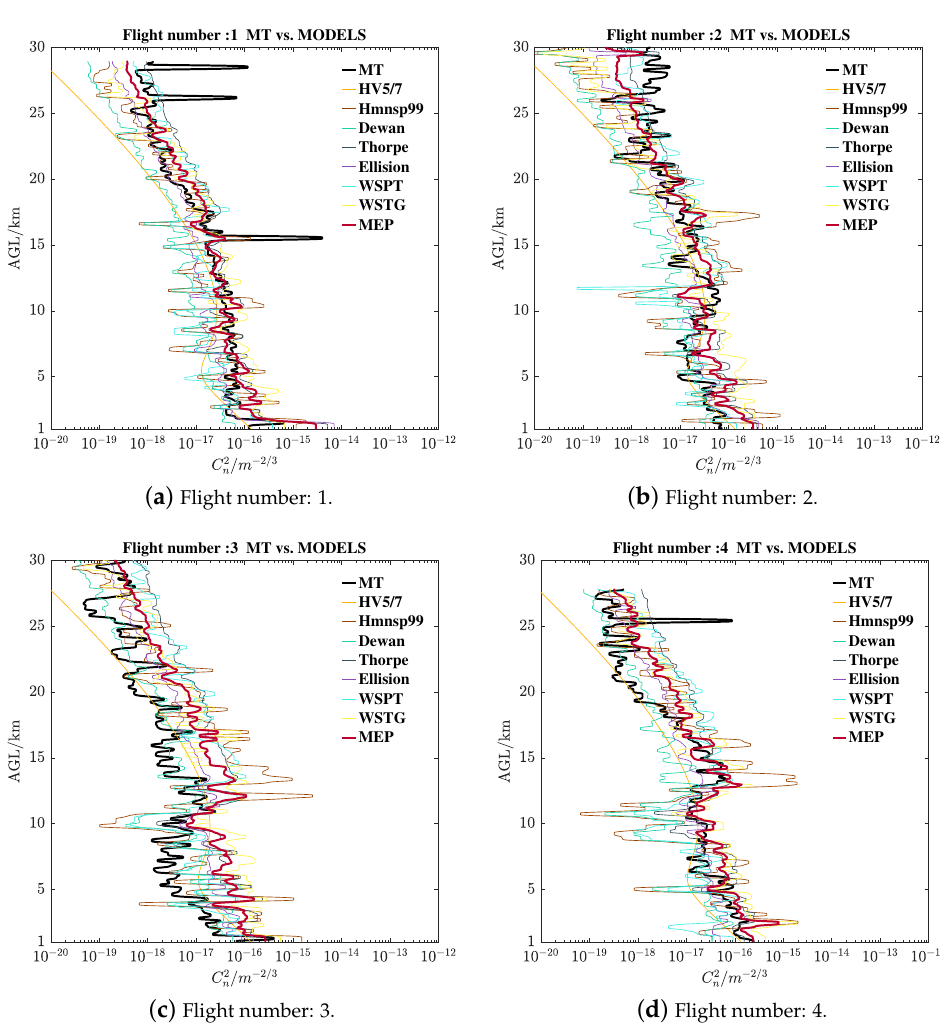
Figure A1. The refractive index structure parameter profiles of MT and estimations in ECACN: Figure A1 sub-figures ( a – d ) are flight numbers 1–4 in Table